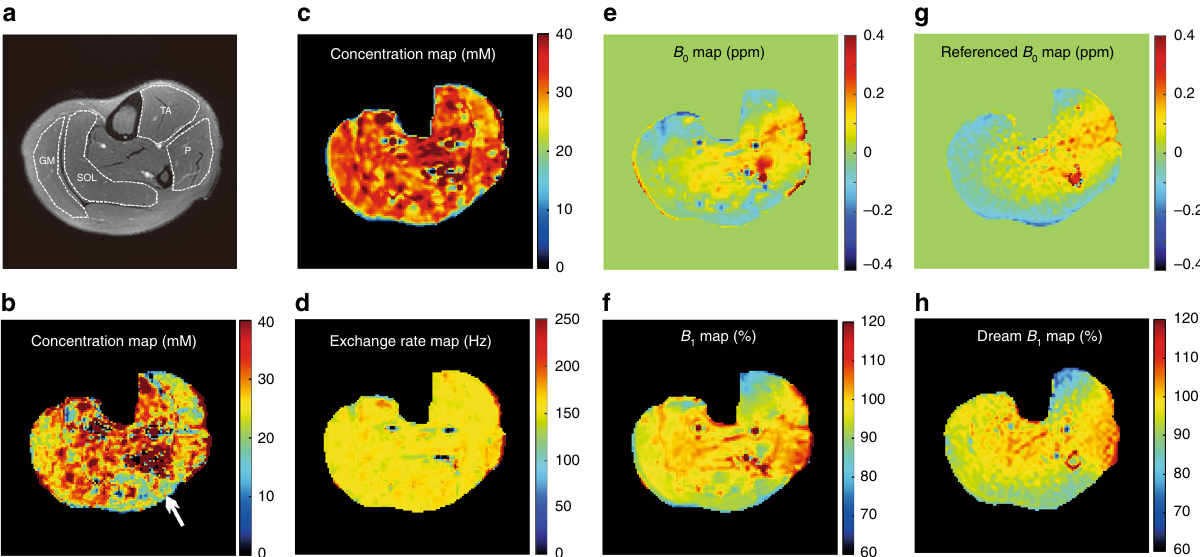
Fig. 4 PCr mapping on human skeletal muscle using ANNCEST. a A high-resolution T 2 weighted anatomy image with segmentation of gastrocnemius medial (GM), soleus (SOL), tibialis anterior (TA), and peroneus (P). b Concentration map obtained using the PLOF method. The PCr concentration ( c ) and exchange rate ( d ) maps together with the B 0 ( e ) and B 1 ( f ) maps obtained by the ANNCEST method using the CEST images acquired with 0.6 μ T saturation power and 800 ms saturation length. The B 1 map was normalized by the reference power 0.6 μ T = 100%. Reference B 0 ( g ) and B 1 ( h ) maps of the same slice obtained by the established dual-echo 22 and DREAM 23 methods, respectively. High-quality PCr mapping on human skeletal muscle using exchange rate, B 0 and B 1 obtained by applying the newly trained ANNCEST . To train the in vivo network, Z spectra of human neural network to the in vivo data are shown in Fig. 4c – f. The skeletal muscle at 3 T were generated assuming the experimen- previously published polynomial and Lorentzian line-shape fi t- tally veri fi ed situation of a single PCr CEST peak at 2.5 ppm and ting (PLOF) method was performed for comparison 17,18 . The results showed that the concentration map obtained by PLOF was an additional broad background signal to account for the con- degraded due to inherent B 0 and B 1 inhomogeneities as indicated tributions from MTC and other metabolites that do not show by the white arrow (Fig. 4b), while the concentration map distinct CEST peaks on the Z spectrum. Maps of concentration, NATURE COMMUNICATIONS| (2020) 11:1072